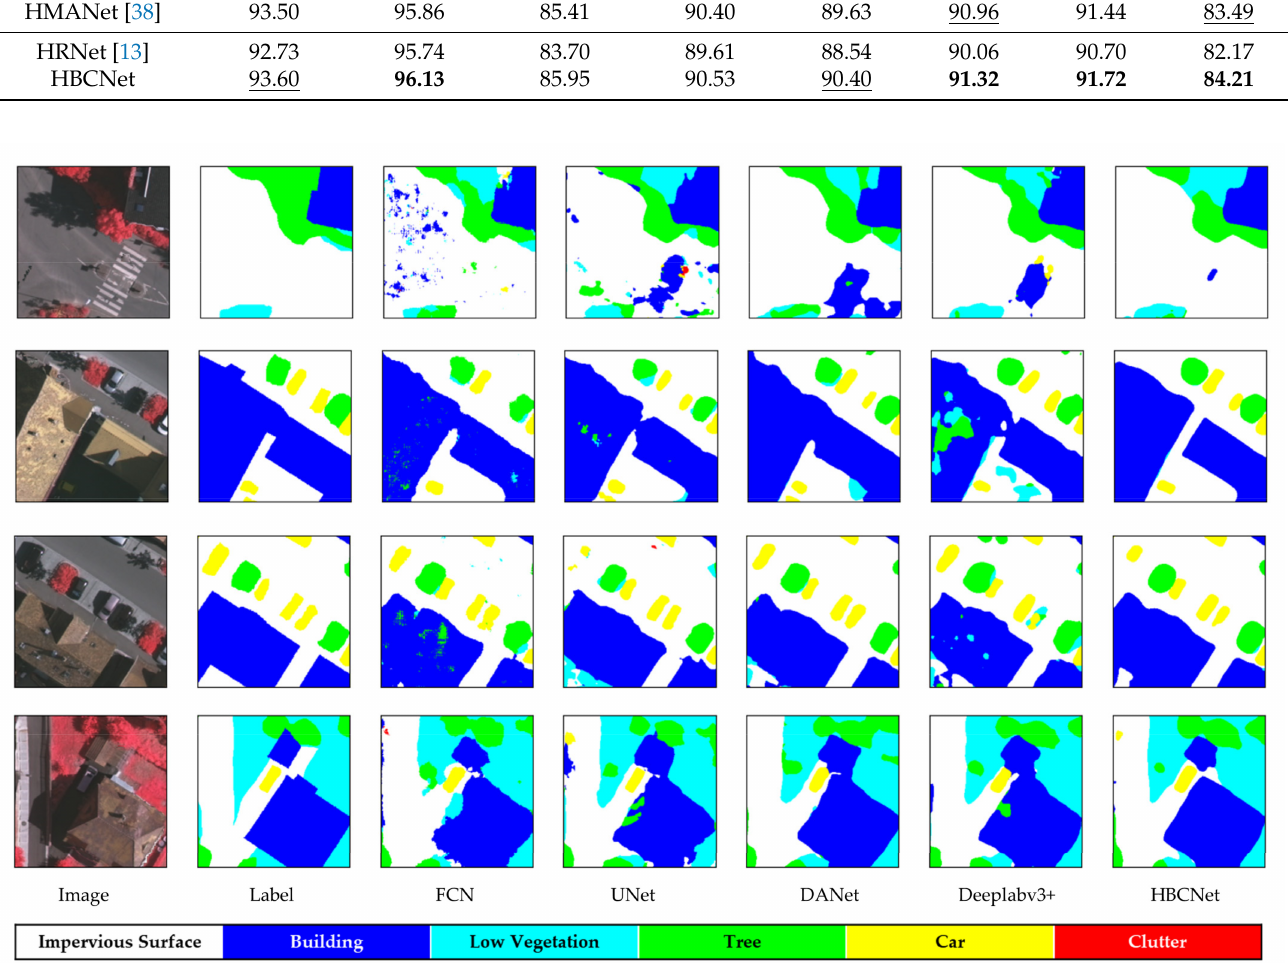
Figure 6. Qualitative comparisons between our method and other models for the Vahingen test dataset. (From left to right ) Columns demonstrate the original images, the image ground truth, the predictions of FCN, UNet, DANet, Deeplabv3+ and the predictions of our